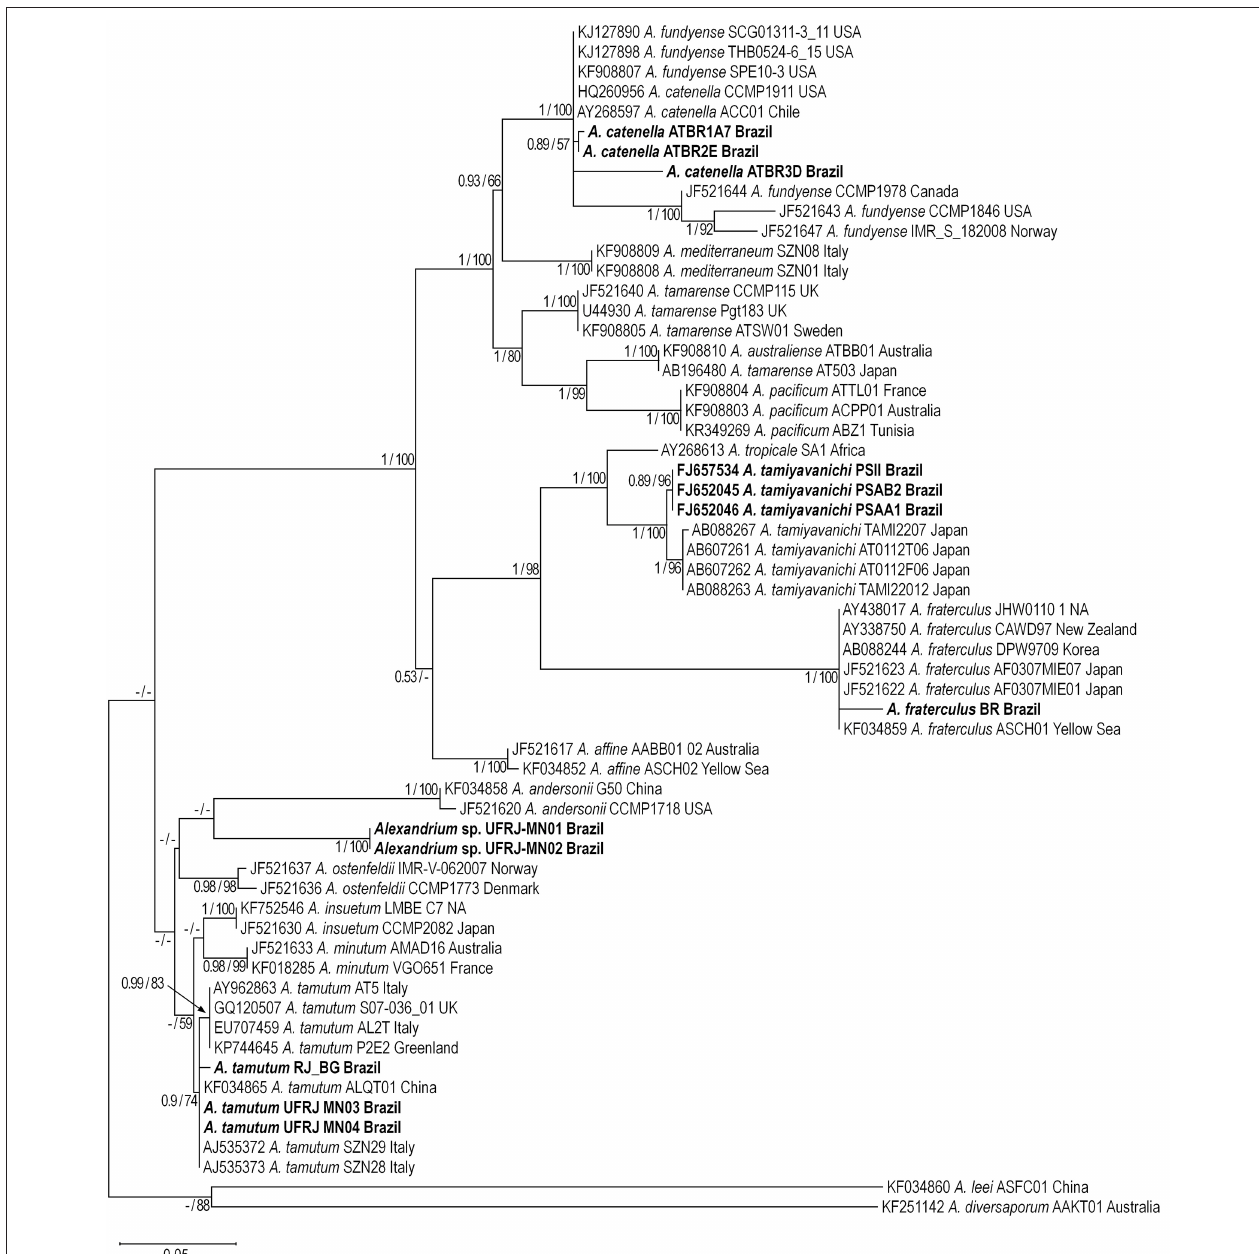
FIGURE 5 | Maximum Likelihood tree based on LSU rDNA sequences. Alexandrium sequences from Brazil are shown in bold. Numbers at nodes are bootstrap and posterior probabilities values for Maximum Likelihood and Bayesian Inference analysis, respectively Only values > 50% (ML) and 0.50 (BI) are shown.